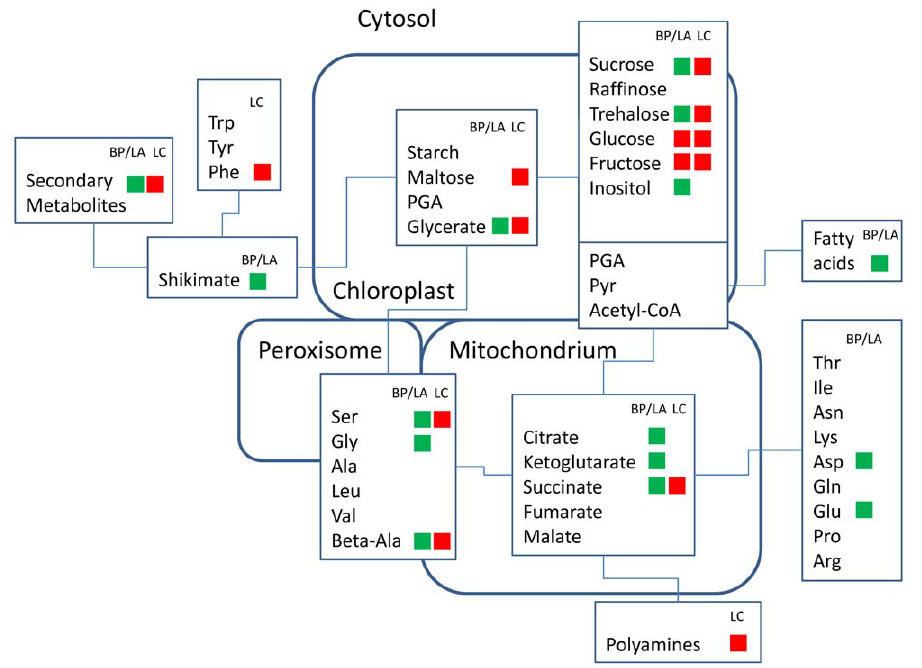
Figure 4. Metabolic signatures of the primary metabolism of small-statured plant species in response to plant diversity. Significant changes were symbolized via heat map (red=relative increase in response to plant diversity; green=relative decrease in response to plant diversity). BE/LA corresponds to relative metabolite concentration changes of Bellis perennis and Leontodon autumnalis in response to species richness. LC corresponds to relative metabolite concentration changes of Lotus corniculatus in response to increasing proportions of legumes.